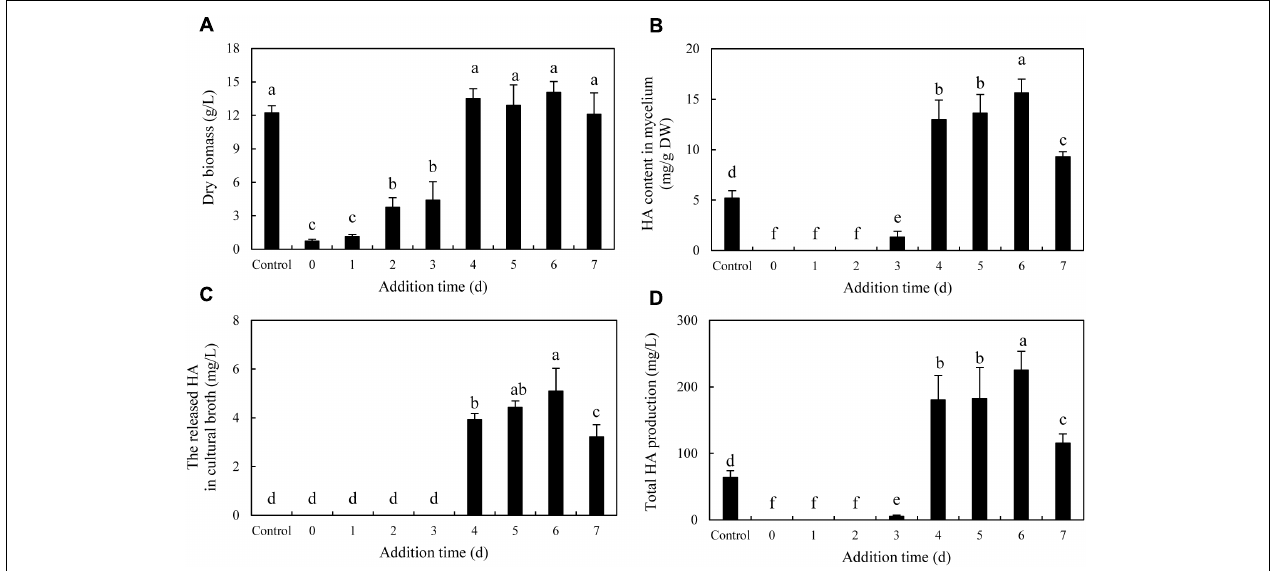
FIGURE 9 | Effect of the addition time of live SB1 on mycelium dry biomass (A) , HA content in mycelium (B) , the released HA in cultural broth (C) , and total HA production (D) in submerged culture of Shiraia sp. S9. The Shiraia culture was maintained in a 150-ml flask containing 50 ml of the liquid medium at 150 rpm and 28 ◦ C for 8 days. Live SB1 was added in the Shiraia cultures on day 0–7 at 400 cells/ml. The control represents the condition with no live SB1 treatment. Values are mean ± SD from three independent experiments. Different letters above the bars mean significant differences ( p < 0.05).